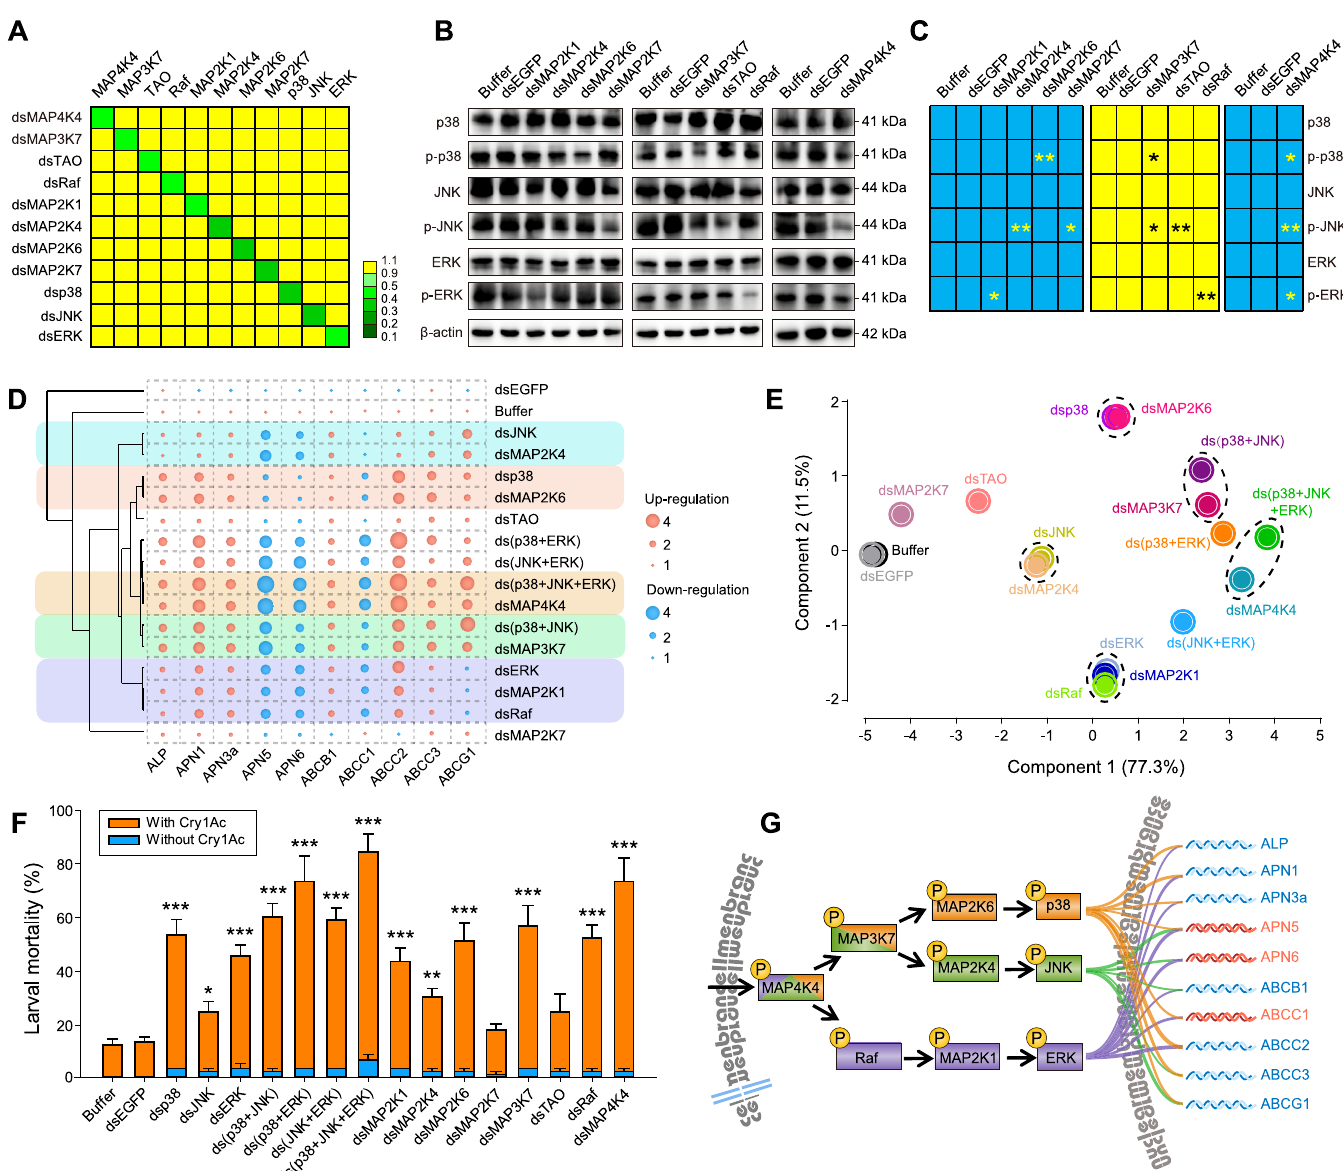
Fig 3. Identification of the MAPK cascades involved in Cry1Ac resistance. (A) The relative expression of different MAPK genes at 48 h post-RNAi. The color-coded expression data is calculated relative to the transcript level for each gene at time 0 h. (B) Western blot analysis of total protein and protein phosphorylation levels of p38, JNK and ERK in resistant NIL-R larvae microinjected with dsRNA targeting MAP2Ks, MAP3Ks or MAP4K. Representative blots are shown. The β -actin protein was analyzed as an internal loading control. (C) Quantification of western blots using ImageJ 1.51 from three biological replicates. � P < 0.05 and �� P < 0.01 by Duncan’s test compared to the controls. (D) Hierarchical clustering of RNAi treated strains analyzing the expression level of resistance-related midgut genes (ALP, APNs and ABC transporters genes). The expression data are from three biological replicates and four technical repeats. (E) Principal component analysis (PCA) of the indicated RNAi- treated strains analyzing the expression level of the target resistance-related midgut genes. (F) Susceptibility to 1000 mg/L Bt Cry1Ac protoxin of NIL-R larvae after RNAi. Data in figures are means and standard errors from three biological replicates. � P < 0.05, �� P < 0.01 and ��� P < 0.001 by Duncan’s test compared to the controls. (G) Schematic representation of the gene regulation landscape of midgut proteins, Cry1Ac-receptors and non-receptor paralogs, involved in Bt Cry1Ac resistance by the activated MAPK signaling cascade pathways. The target downstream midgut resistance-related genes with red color indicated that they were up-regulated, while those with blue color indicated that they were